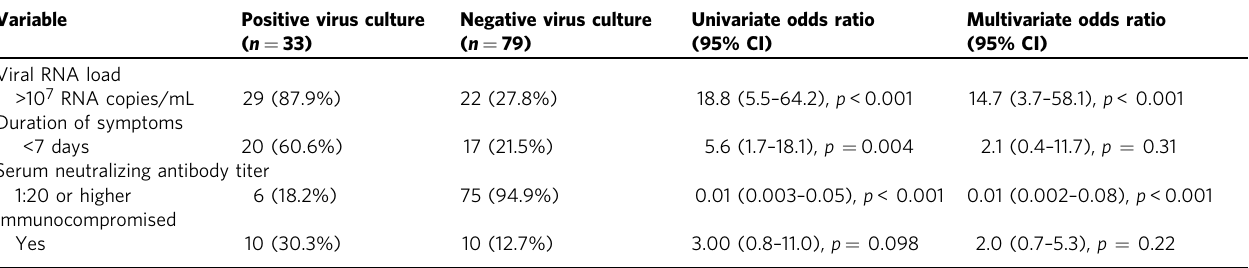
Table 3 Univariate and multivariate analysis of key determinants for infectious virus